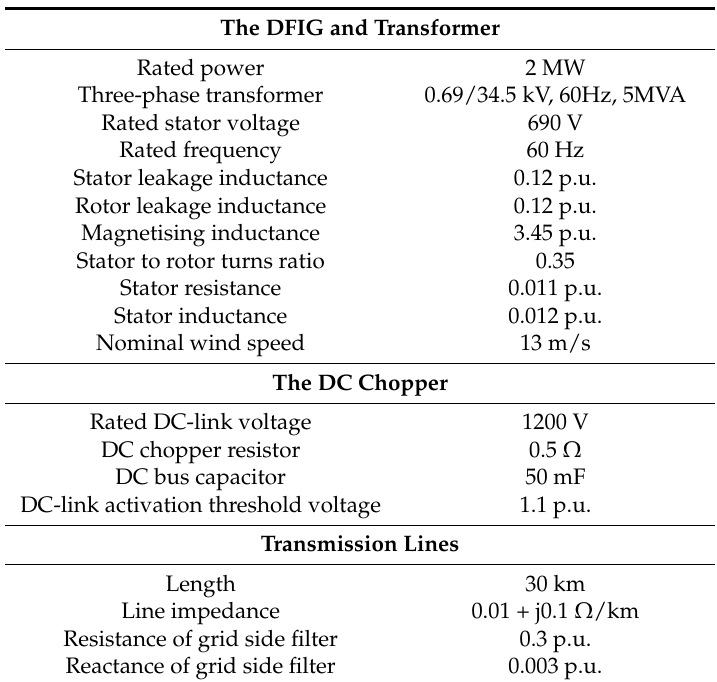
Table 2. Simulated DFIG